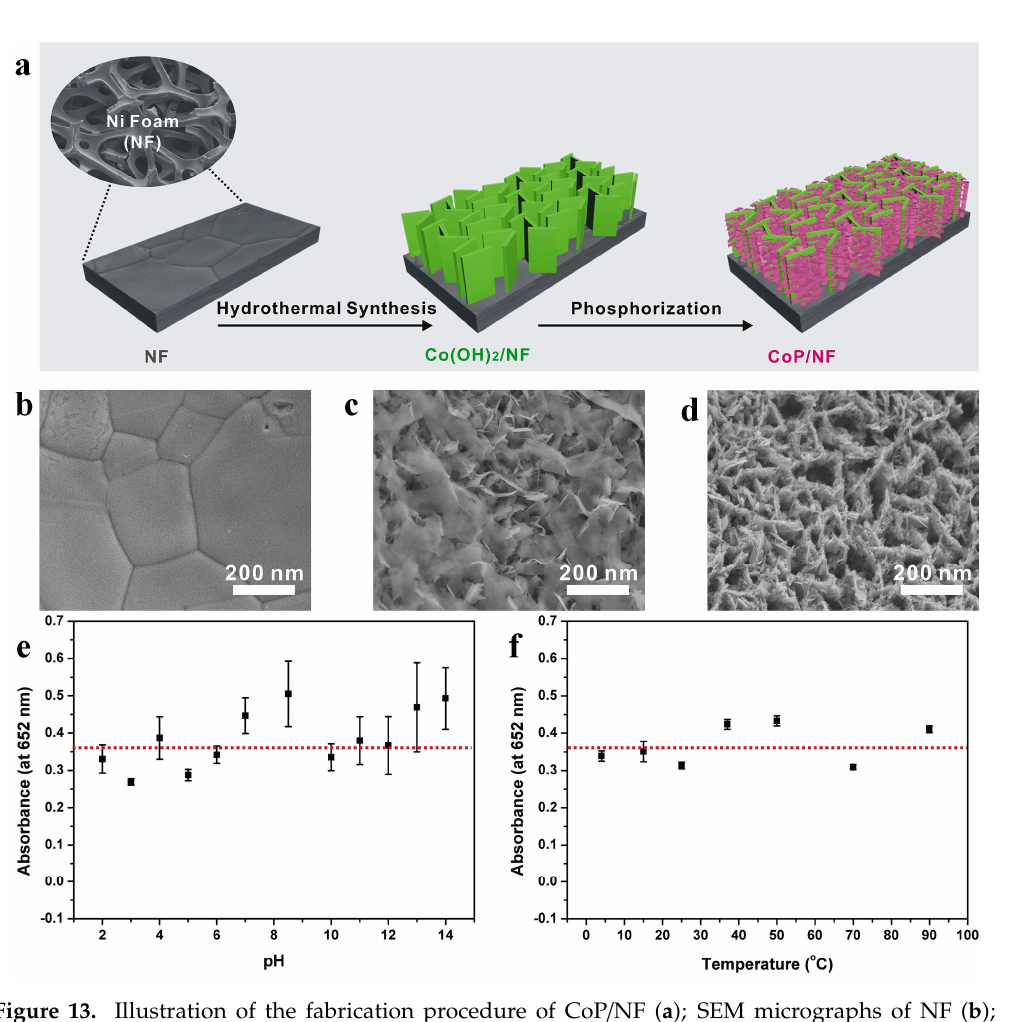
Figure 13. Illustration of the fabrication procedure of CoP/NF ( a ); SEM micrographs of NF ( b ); Co(OH) 2 /NF ( c ) and CoP/NF ( d ); the robustness and versatility of the CoP/NF nanozyme against harsh pH ( e ) and temperature ( f ). Reprinted from (Uricase-free on-demand colorimetric biosensing of uric acid enabled by integrated CoP nanosheet arrays as a monolithic peroxidase mimic. 1021, He, Y. F.; Qi, F.; Niu, X. H.; Zhang, W. C.; Zhang, X. F.; Pan, J. M., Anal. Chim. Acta 2018 , 1021, 113–120) Reference [142]. Copyright (2020), with permission from